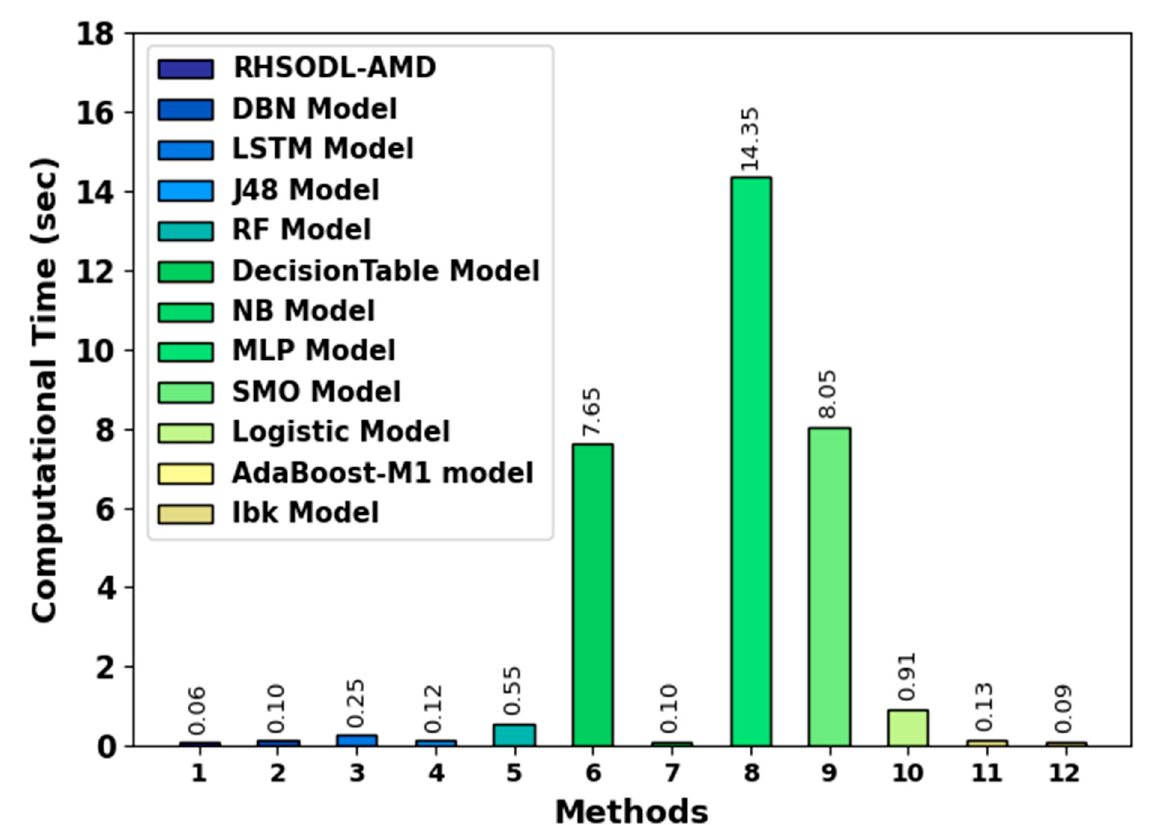
Figure 10. Comparative CT analysis of the RHSODL-AMD.